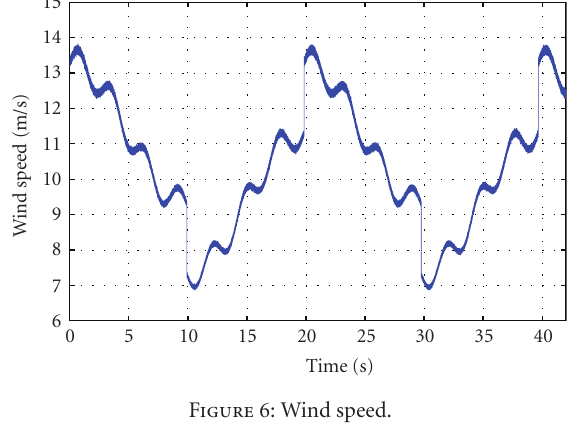
Figure 6: Wind speed.